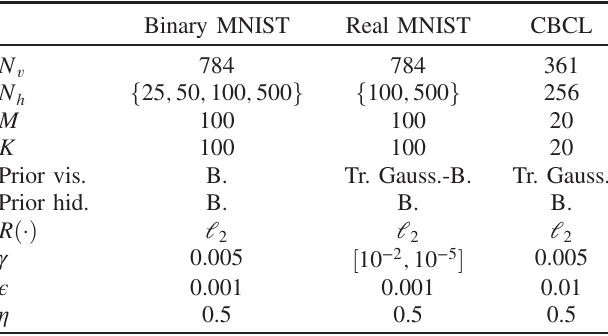
TABLE I. Parameter settings for GRBM training.